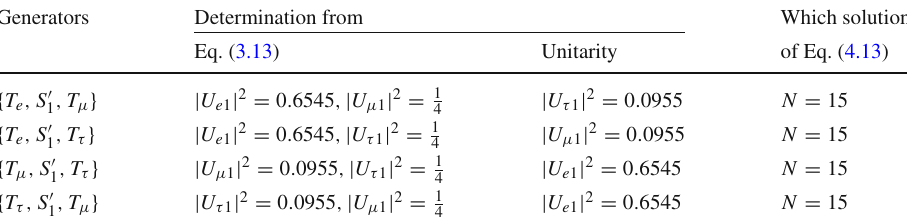
Table 3 Allowed generators for Generators Determination from Which solution the group H 3 (Note: This group Eq. (3.13) Unitarity of Eq. has GAP identifier [ 120,35 ])